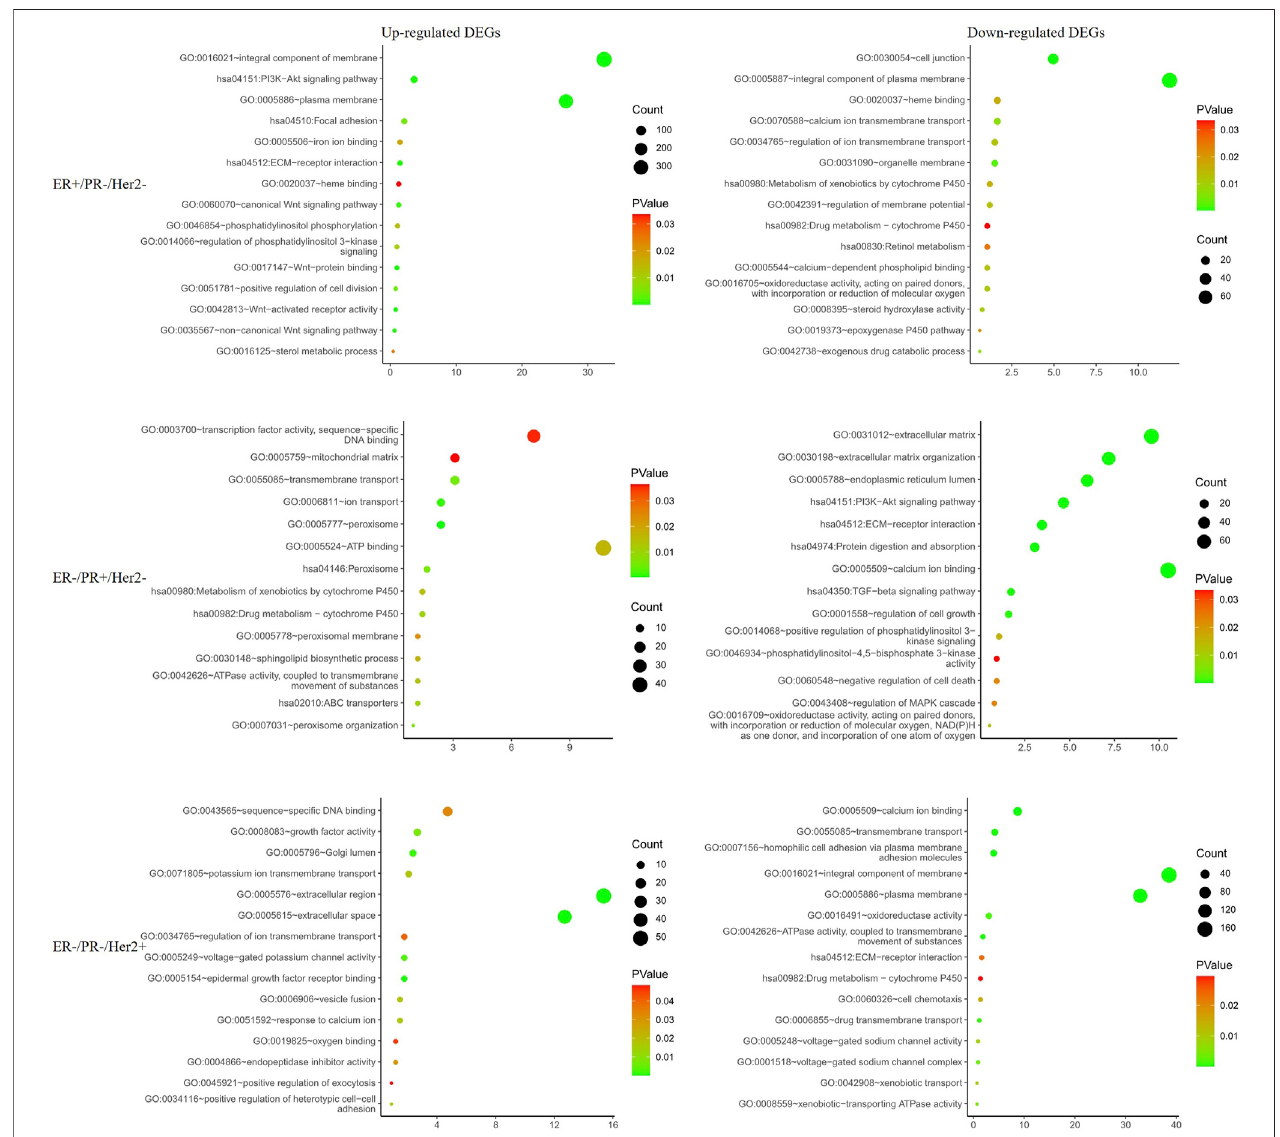
FIGURE 3 | Functional enrichment analysis of the differentially expressed genes in different hormone and Her2 receptor